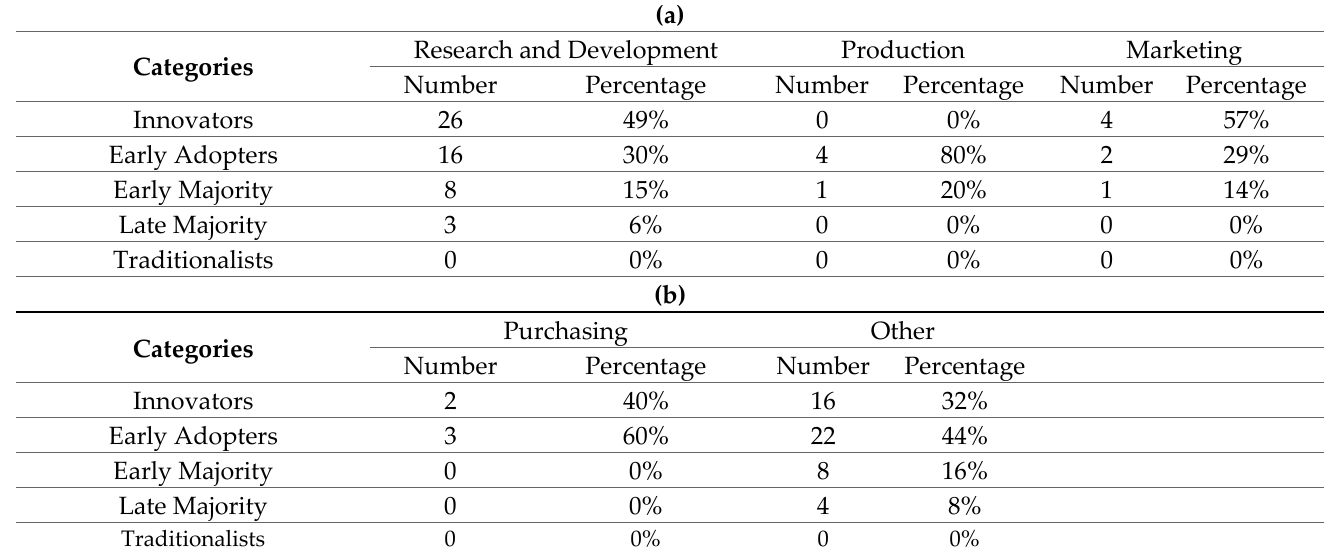
Table 10. Analysis according to the